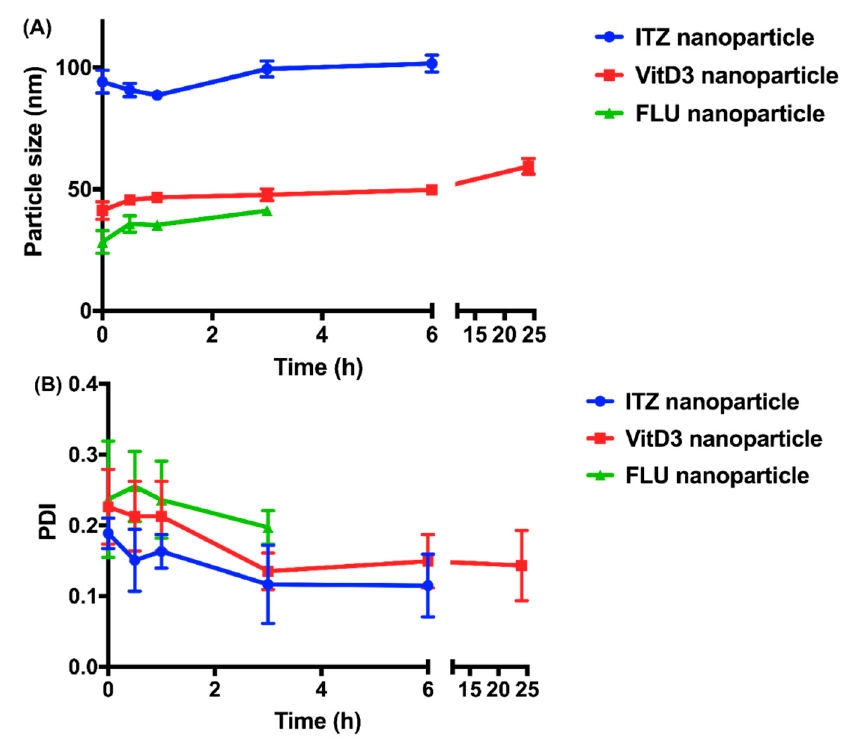
Figure 4. The time-course changes in ( A ) particle size (nm) and ( B ) polydispersity index (PDI) of nanoparticles stored at room temperature.